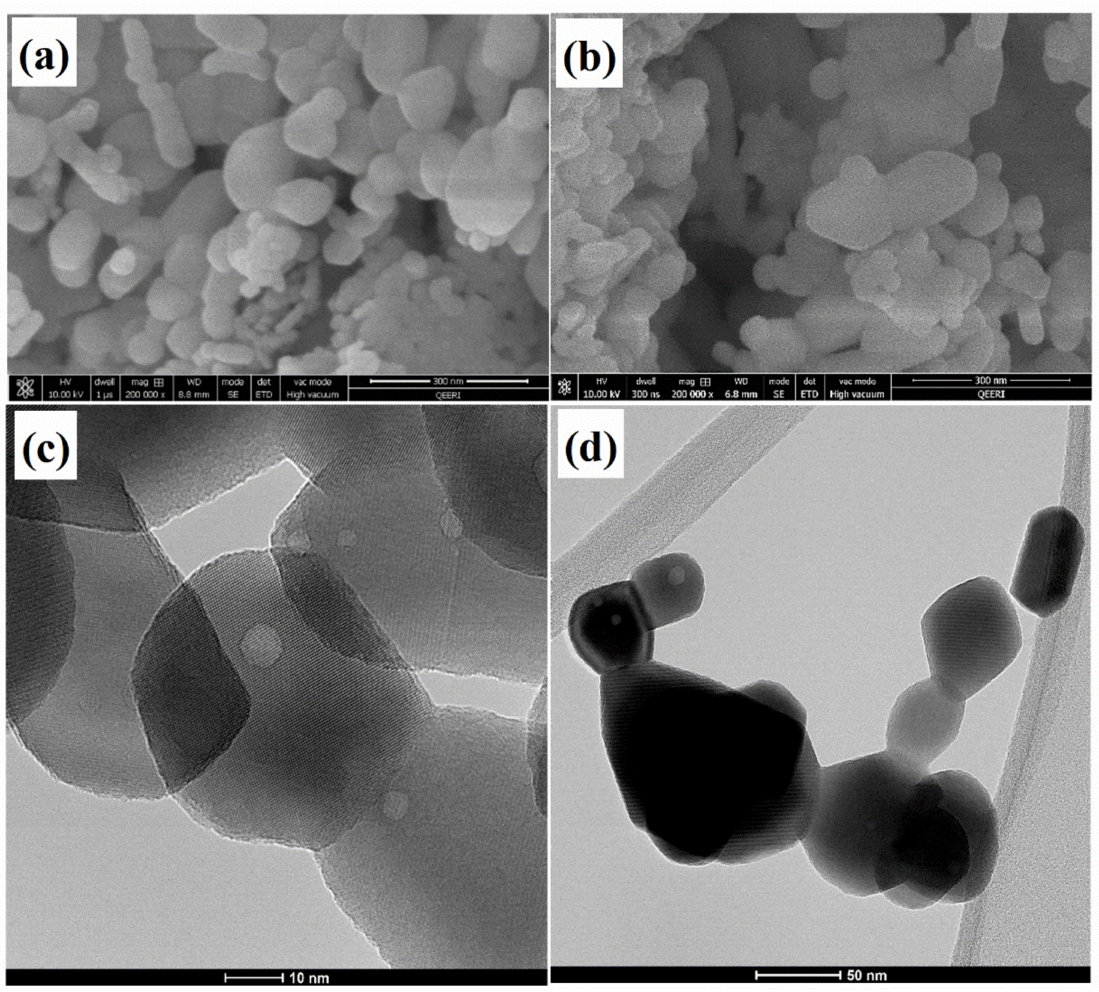
Figure 2. ( a , b ) FE-SEM, ( c , d ) TEM images of Y 2 O 3 and Y 2 O 3 /IMD.